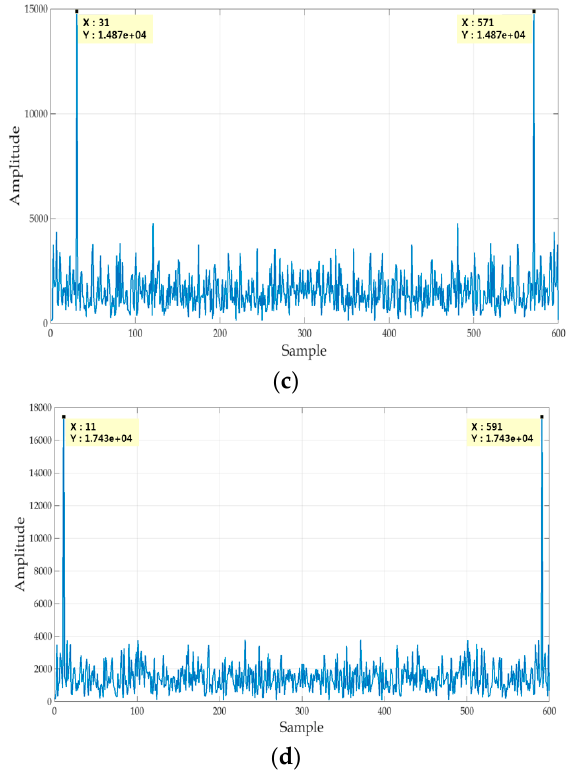
Figure 12. FFT results; ( a ) 𝑓 (cid:3005) = 1 kHz; ( b ) 𝑓 (cid:3005) = 2 kHz; ( c ) 𝑓 (cid:3005) = 3 kHz; ( d ) 𝑓 (cid:3005) = −1 kHz;